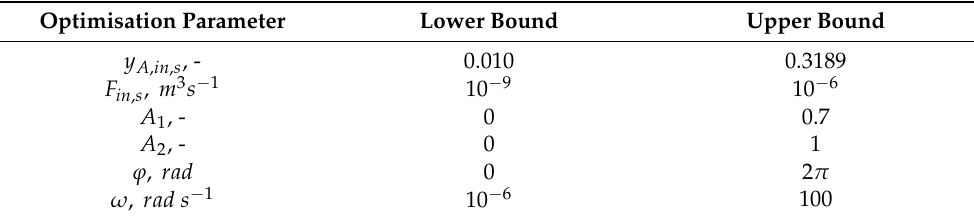
Table 5. Lower and upper bounds for the six parameters used in the multi-objective NFR optimisation for Case 5.